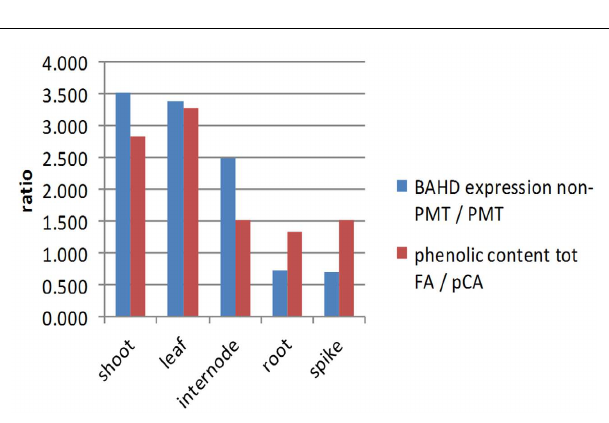
FIGURE 4 | Bound hydroxycinnamic acid content from developing Brachypodium tissues estimated by HPLC. Samples were early vegetative plants (EVP), late vegetative plants (LVP), transition phase leaves (TPL), transition phase internodes (TPI4,TPI3), transition phase roots (TPR), reproductive phase leaves (RPL), reproductive phase internodes (RPI4, RPI3, RPI2), advanced phase spike (APS), advanced